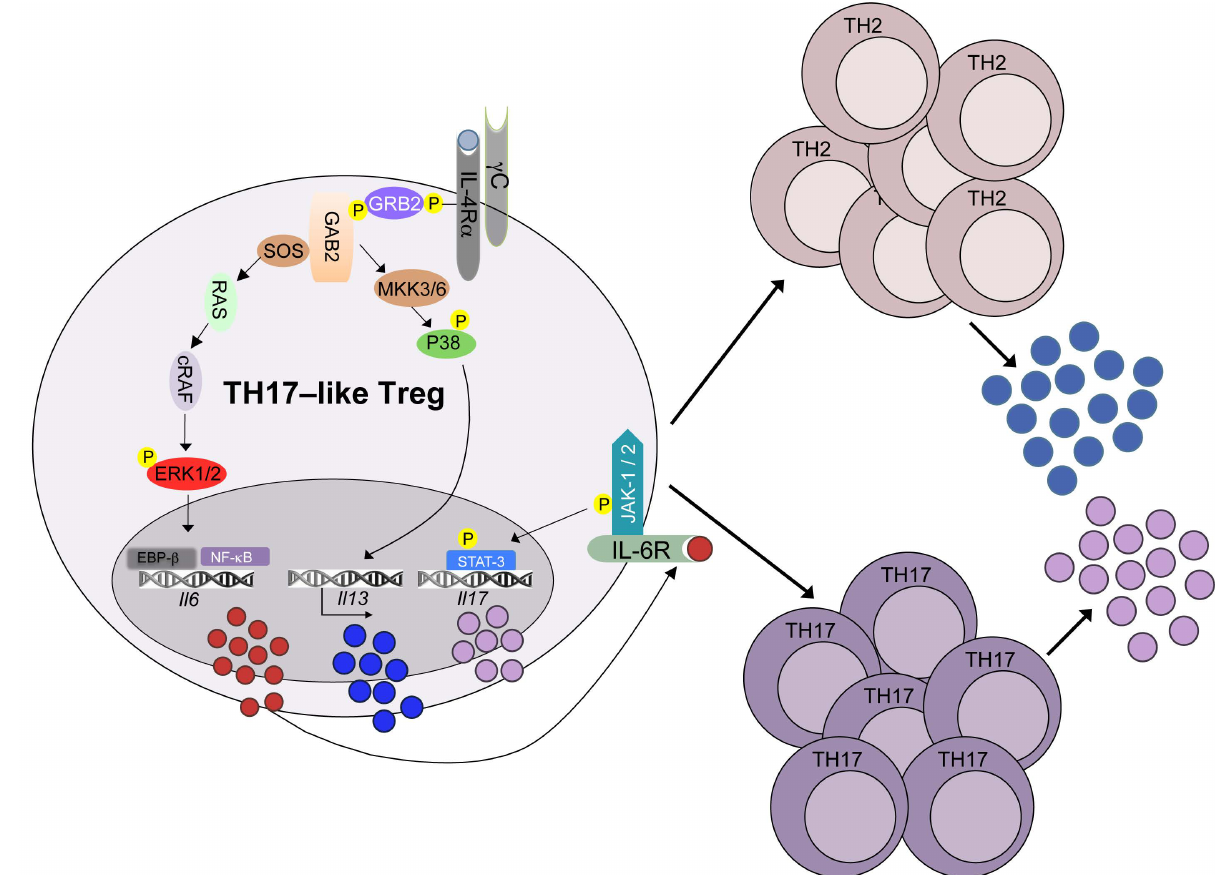
Figure 3. Induced regulatory T (iTreg) cell subversion by the asthma-promoting IL-4R α -R576 variant. Schematic representation of pathways mediating iTreg cell subversion by the asthma-promoting IL-4R α -Q76R variant. The glutamine to arginine substitution at position 576 of IL-4R α chain allows recruitment of the protein adaptor GRB2 upon receptor activation. GRB2 activates downstream MAP kinase cascades, including extracellular signal–regulated kinases, which drive IL-6 production by activating the transcription factors NF- κ B and C/EBP- β , and p38 MAP kinase, which activates IL-13 production. Newly formed antigen-specific iTreg cells are subsequently destabilized, resulting in the generation of excessive TH2 and TH17 cell responses that promote severe airway